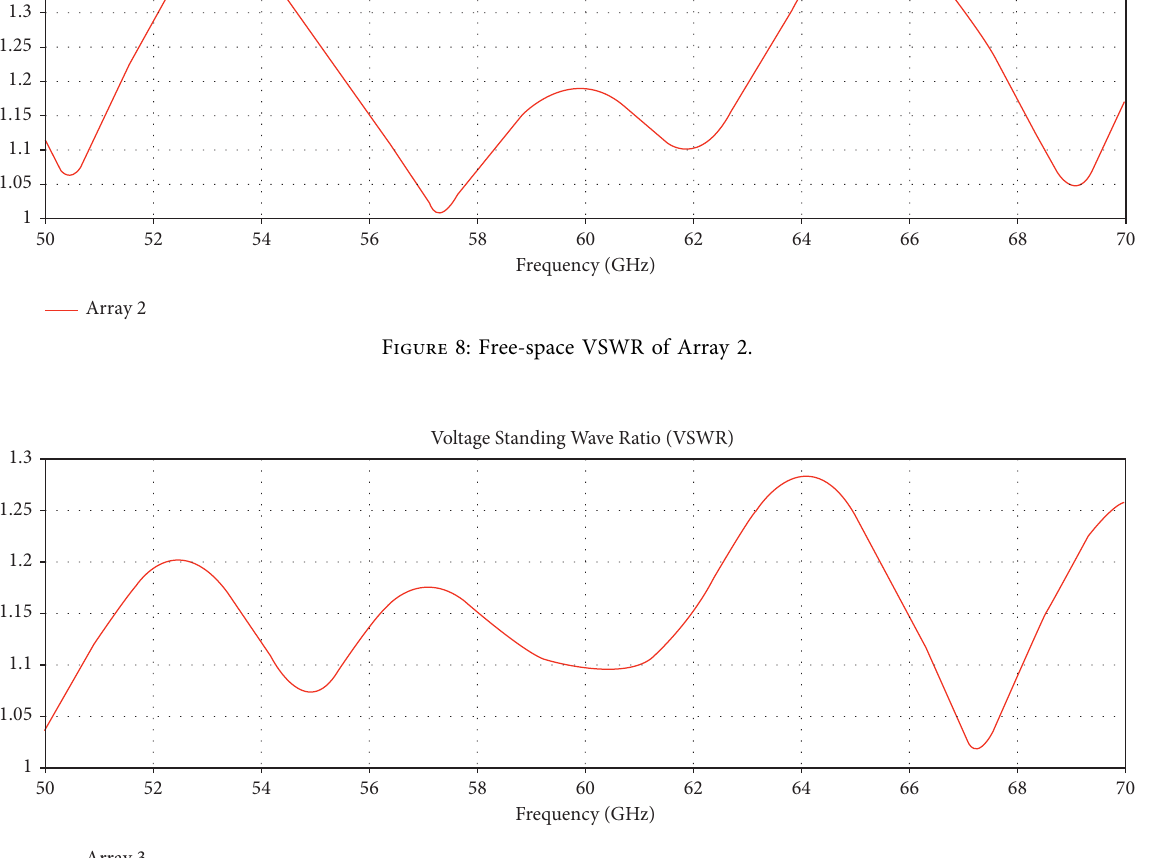
Figure 9: Free-space VSWR of Array